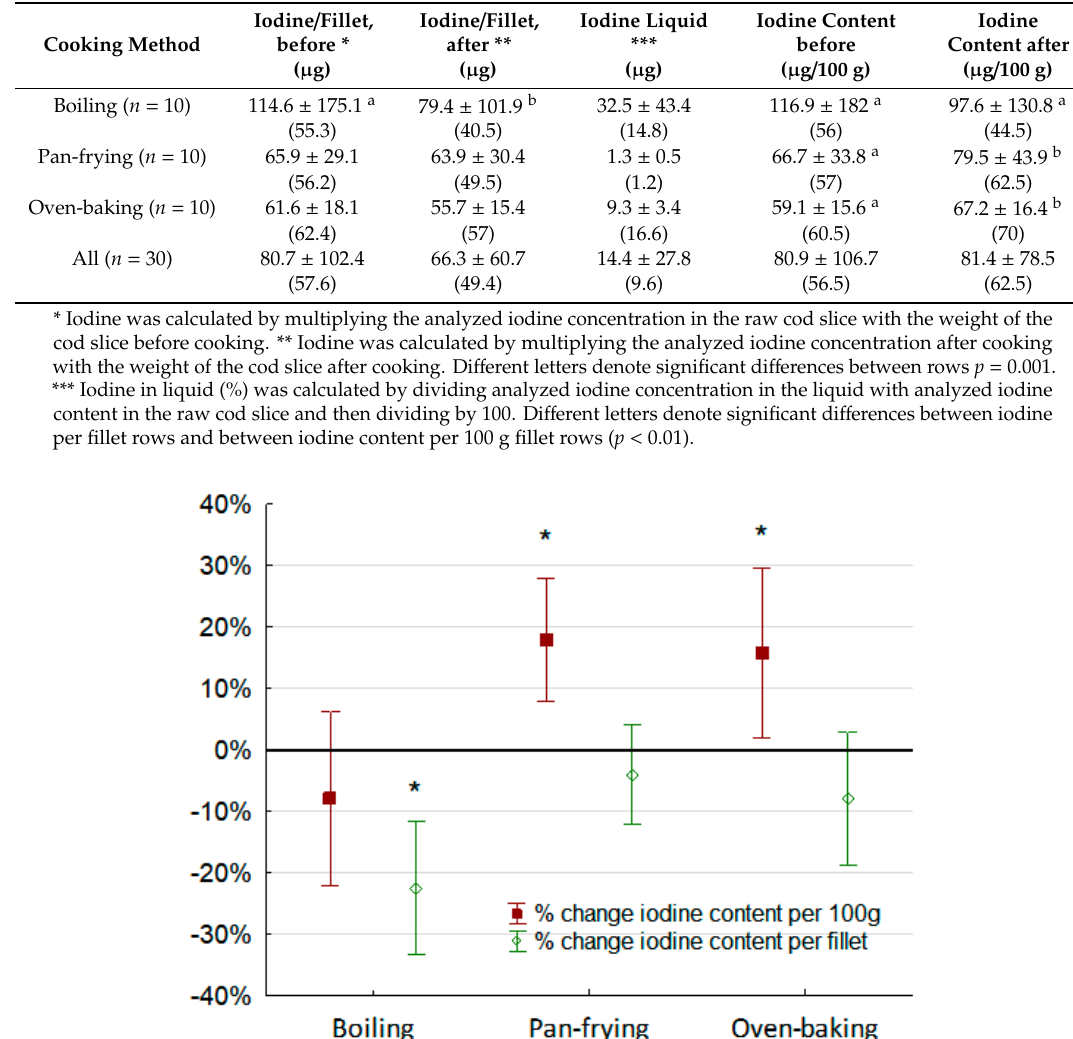
Table 3. Total iodine ( μ g) per piece of cod fillets and in the associated liquid ( μ g), and iodine content ( μ g/100 g) in cod fillets before and after the different cooking methods. Numbers are given as mean ± SD and (median) wet weight.